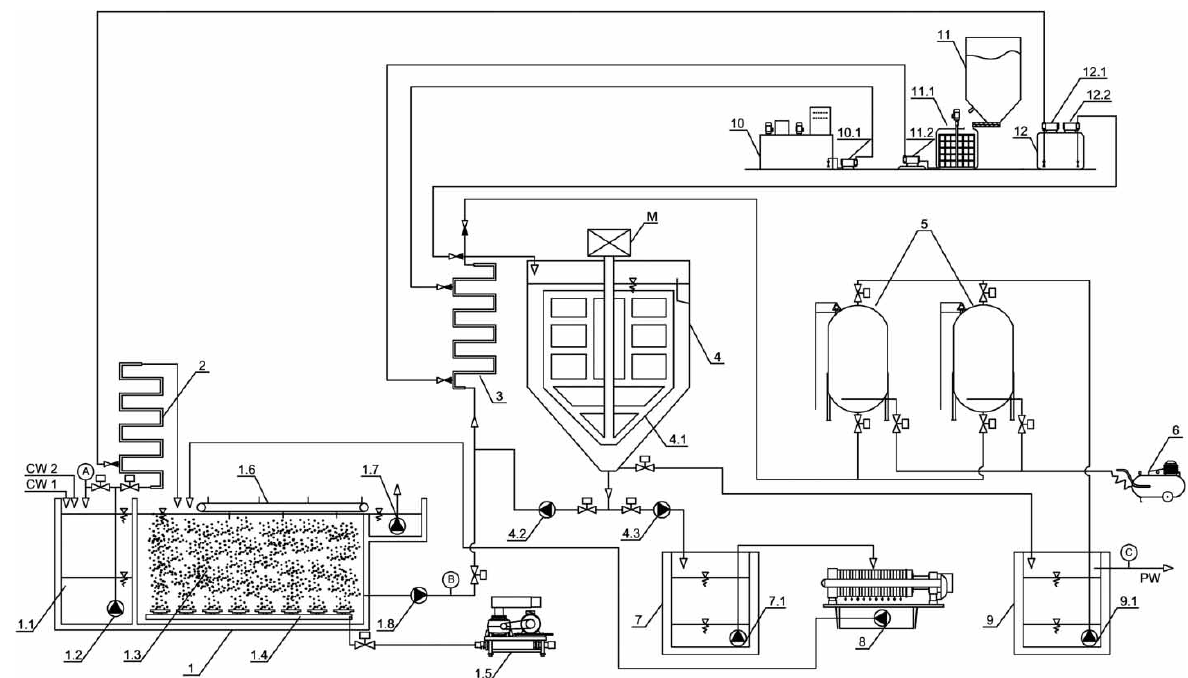
Fig. 1. Flowchart of the experimental installation; CW1 and CW2 (cid:1) raw wastewaters from vegetable and animal fat production plants; PW (cid:1) pretreated mixed wastewater; 1 (cid:1) two-chamber storage-average tank for raw wastewater; 1.1 (cid:1) preliminary averaging chamber with bypass; 1.2 (cid:1) bypass pump; 1.3 (cid:1) aerated preliminary chamber; 1.4 (cid:1) set of aerating diffusers; 1.5 (cid:1) compressor; 1.6 (cid:1) flotate skimmer; 1.7 (cid:1) pump for thickened fatty flotate; 2 (cid:1) preliminary pipe reactor; 3 (cid:1) 2nd stage pretreatment pipe reactor; 4 (cid:1) batch process reactor; 4.1 (cid:1) gate agitator; 4.2 (cid:1) wastewater circulation pump; 4.3 (cid:1) sludge pump; 5 (cid:1) saturation station for pretreated wastewater; 6 (cid:1) compressor; 7 (cid:1) sludge thickening tank; 8 (cid:1) frame filter press; 9 (cid:1) pretreated wastewater tank; 9.1 (cid:1) wastewater tank; 10 (cid:1) flocculant preparation and metering unit; 10.1 (cid:1) flocculant pump; 11 (cid:1) CaO storage bunker; 11.1 (cid:1) milk of lime preparation unit; 11.2 (cid:1) pump for milk of lime; 12 (cid:1) perhydrol unit; 12.1 and 12.2 (cid:1) perhydrol pumps; M (cid:1) mixer drive unit with gear-motor; A, B and C (cid:1) wastewater sampling points for